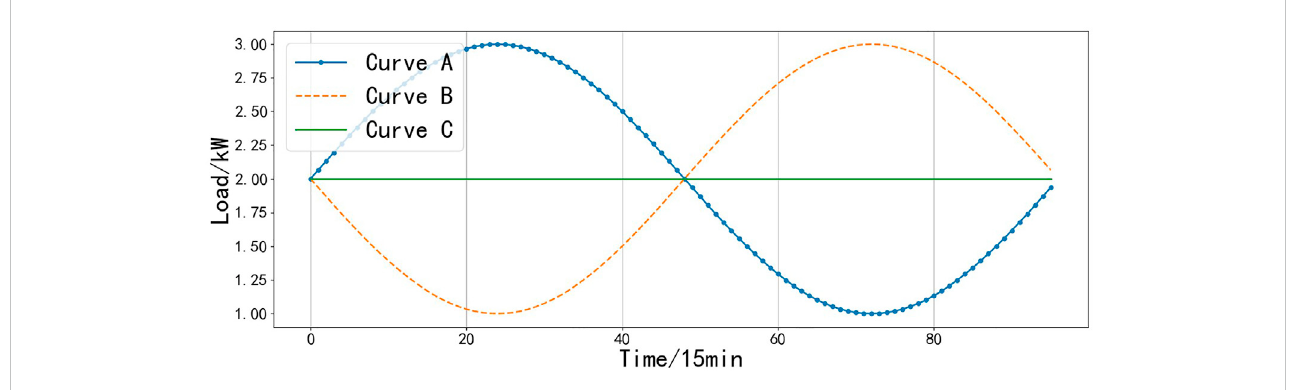
FIGURE 1 Three types of residential load curve.